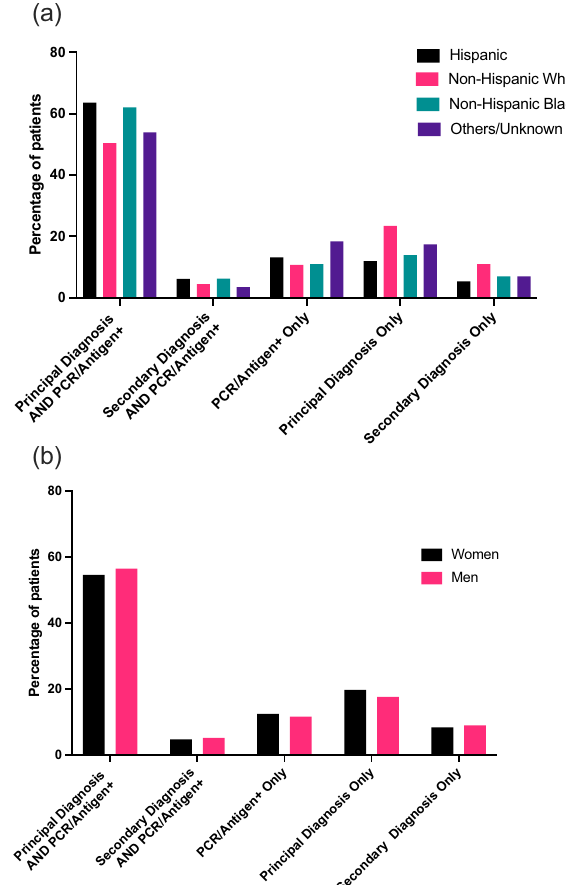
Fig. 3 Demographic differences in SARS-CoV2 phenotyping strategies. Computable phenotypes for SARS-CoV-2 infection by a Race/Ethnicity and b Sex in the Yale-New Haven Health (80.5%, n = 2378), but the proportion was similar between Mayo